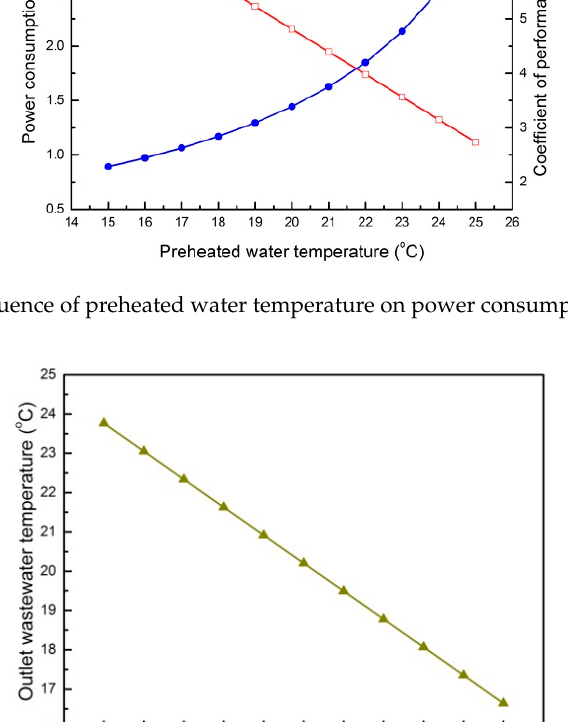
Energies 2016 , 9 , 1026 12 of 16